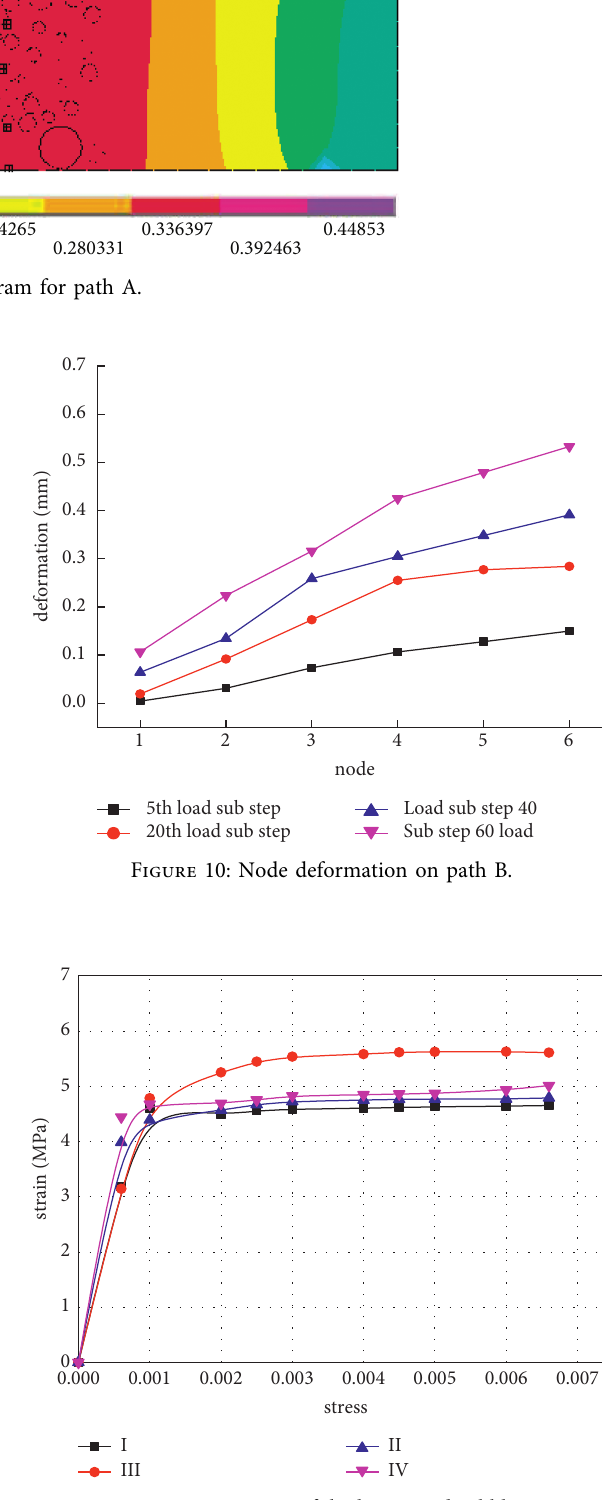
Figure 11: Stress-strain curve of the large sized cobble concrete at different